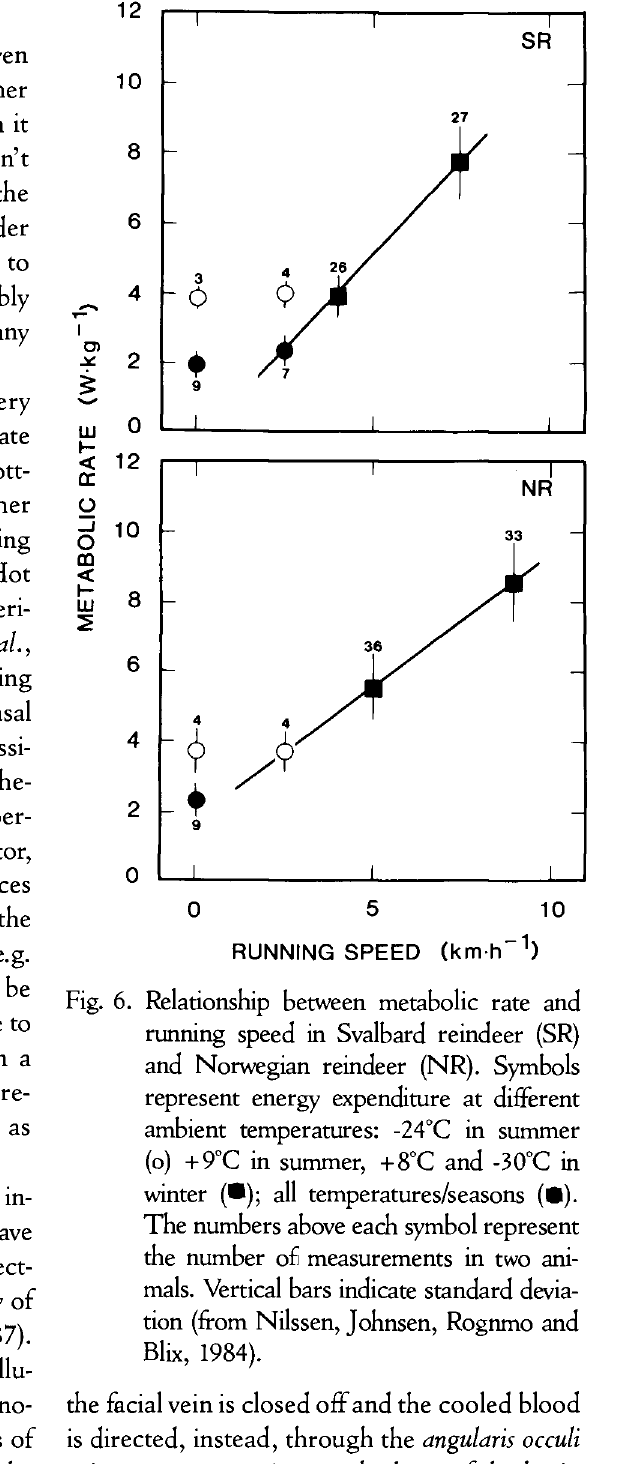
Fig. 6. Relationship between metabolic rate and running speed in Svalbard reindeer (SR) and Norwegian reindeer (NR). Symbols represent energy expenditure at different ambient temperatures: -24°C in summer (o) +9°C in summer, +8°C and -30°C in winter (•); all temperatures/seasons (•). The numbers above each symbol represent the number of measurements in two ani mals. Vertical bars indicate standard devia tion (from Nilssen, Johnsen, Rognmo and Blix,